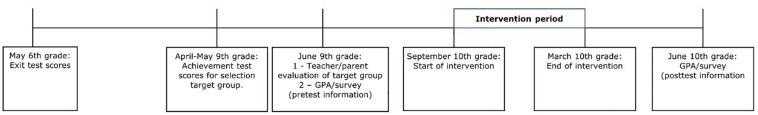
Timeline of the intervention.